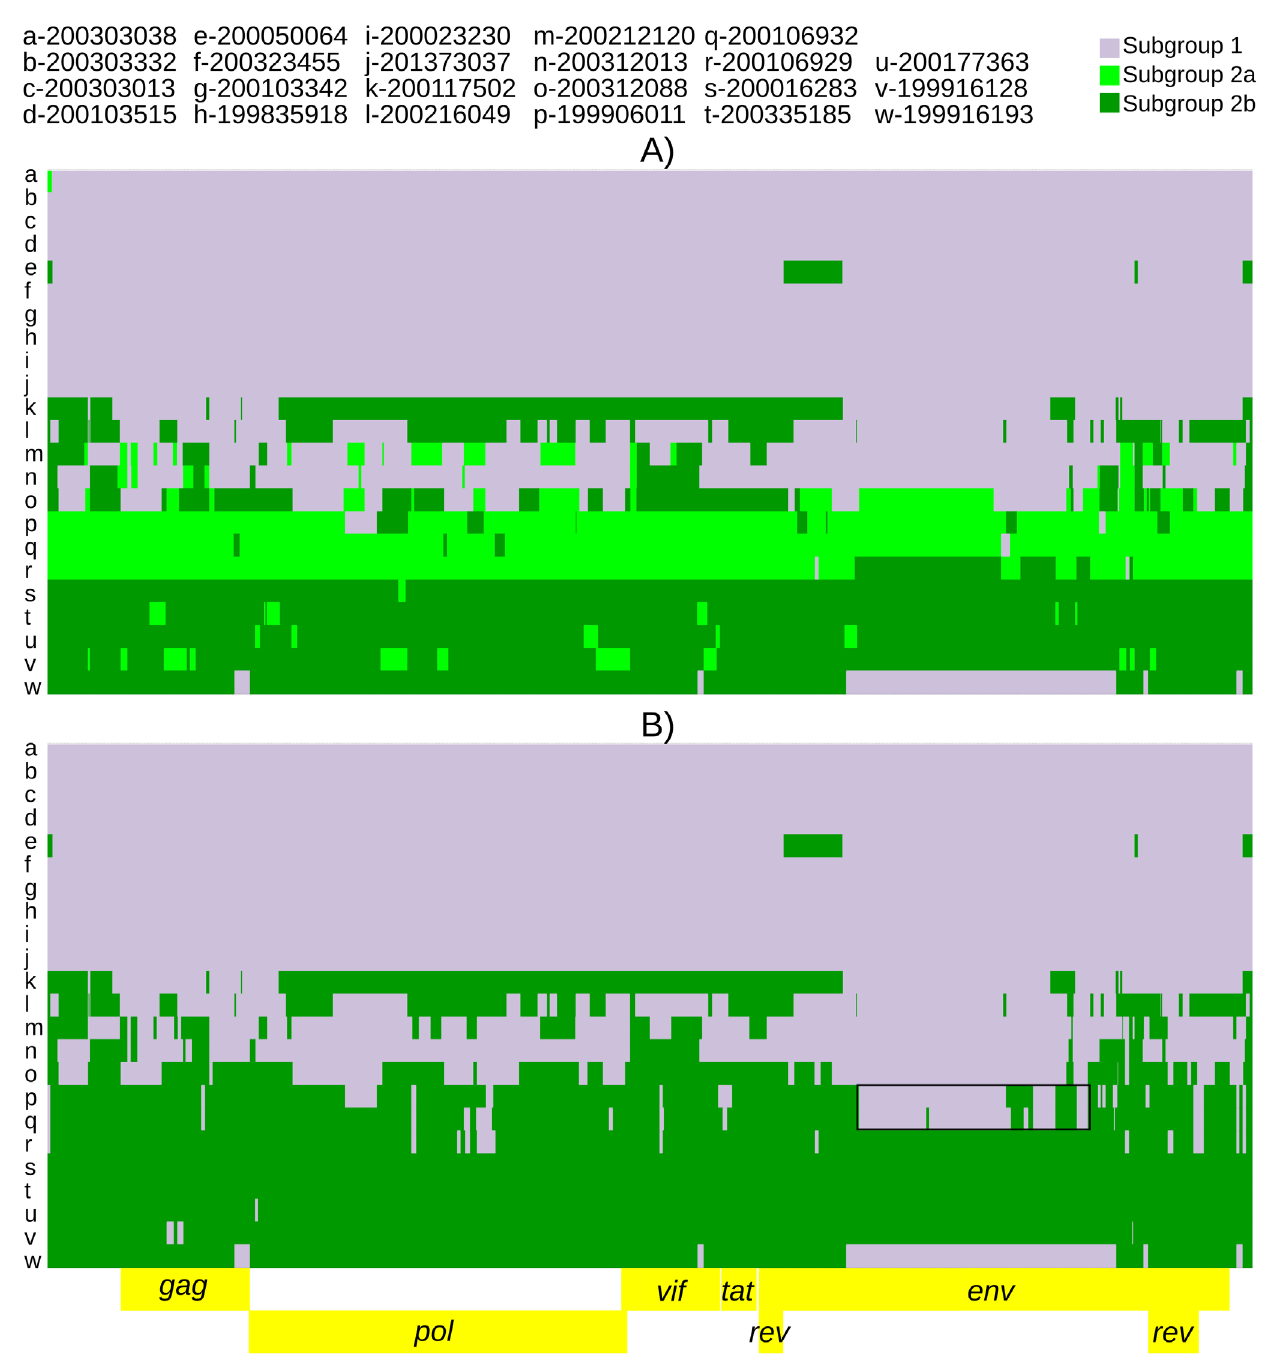
Figure 3. Twenty-three SRLV subtype A2 genomes ‘painted’ with recipient genomic ‘chunks’ derived from subgroup-specific donor genomes. The recombination models utilized were ( A ) subgroup1 vs subgroup 2a vs subgroup 2b and ( B ) subgroup 1 vs subgroup 2b. The black boxes highlight large subgroup 1 recombination blocks in subgroup 2a genomes.